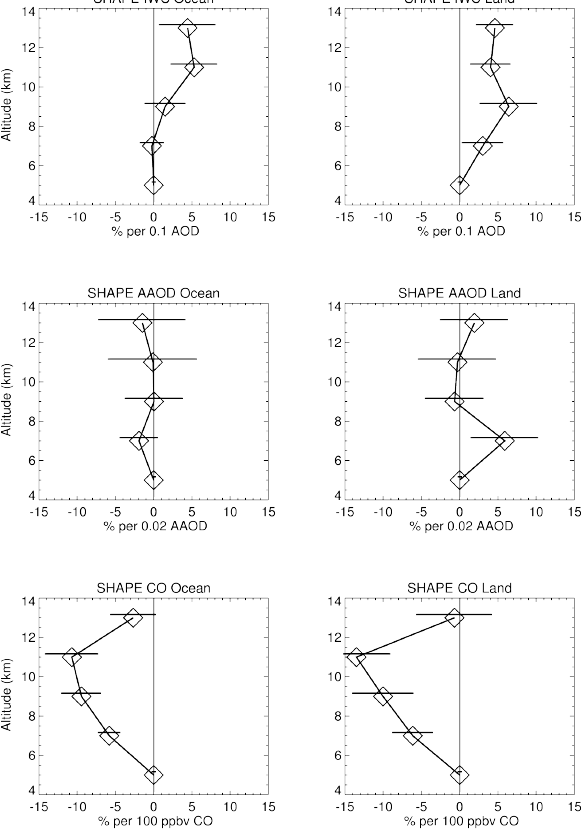
Figure 15. Average IWCshape derivatives over ocean and land for AOD, AAOD, and CO. Derivatives were used when they were less than 100% per 0.10 AOD, 100% per 0.02 AAOD, and 100% per 100ppbv CO. Confidence limits (1 σ) of the determination of the means are indicated by the horizontal